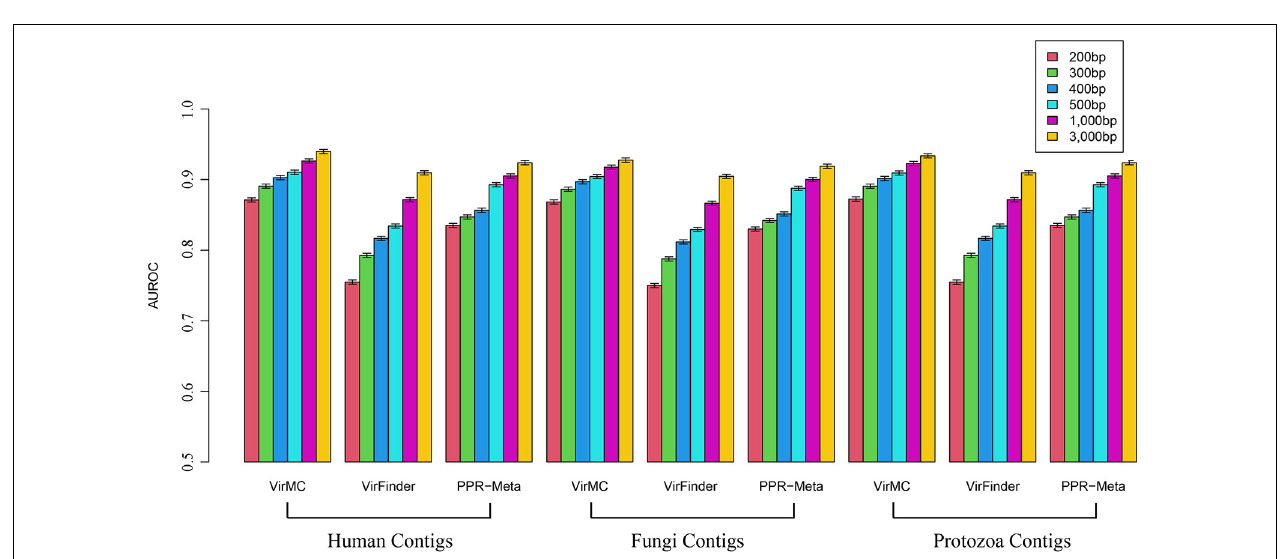
FIGURE 5 | The AUROC values of VirMC, VirFinder, and PPR-Meta in predicting viral contigs from contaminated metagenomic samples with Human, Fungi, and Protozoan sequences. The contigs were randomly sampled from Human, Fungi, and Protozoan genomes to combine with viral and bacterial contigs in testing datasets,